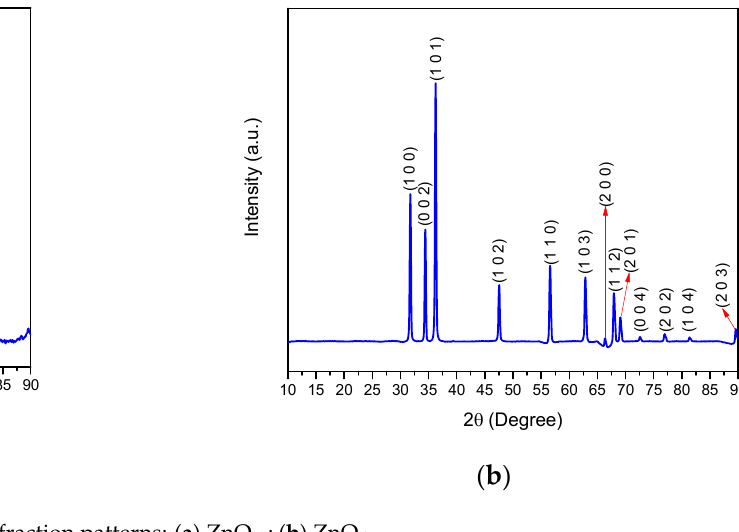
Figure 4. X-ray diffraction patterns: ( a ) ZnO N ; ( b ) ZnO A . Table 1. Bandgap energy ( E g ), crystallite size, d -spacing values, and textural properties of ZnO N and ZnO A materials.